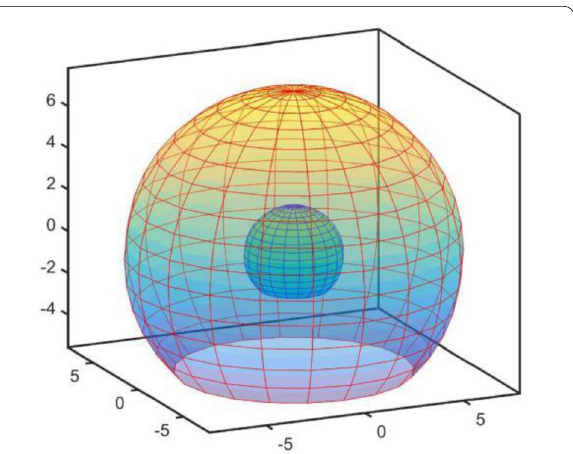
Figure 13 Thrust F AN under mechanism deformation